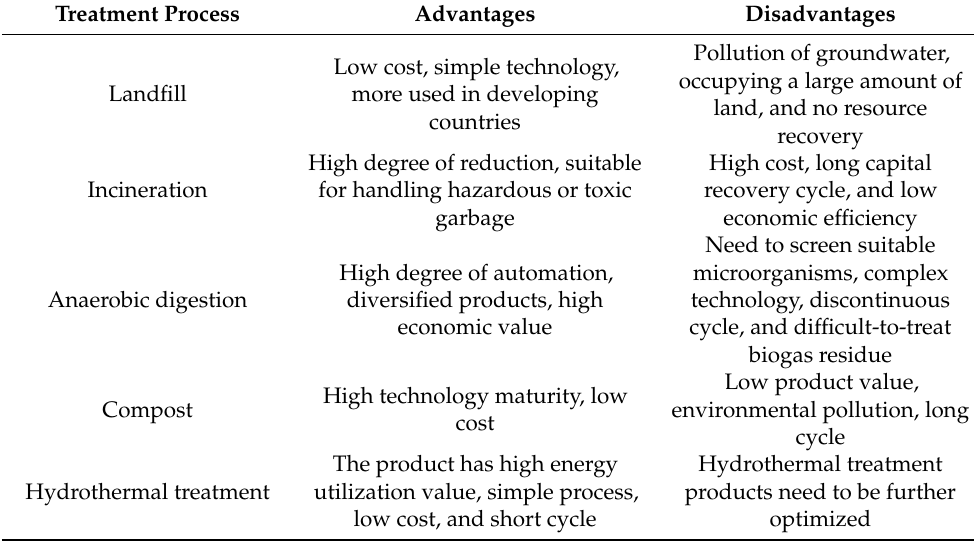
Table 1. Advantages and disadvantages of different food waste treatment